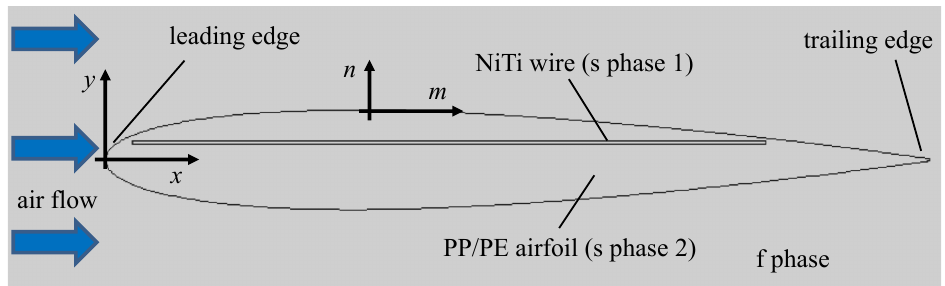
Figure 2. Detail of the control volume under scrutiny, with indication of solid and fluid phases. Global x − y (centered on the leading edge) and local m − n coordinates are also